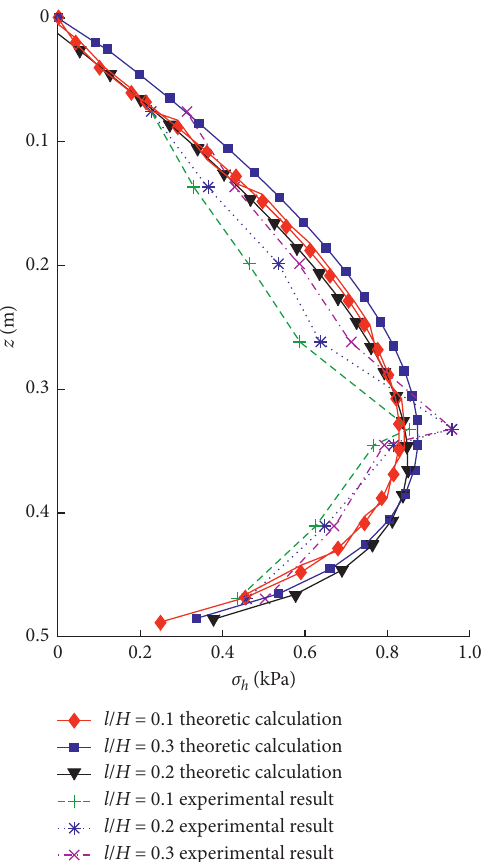
Figure 12: Distribution of earth